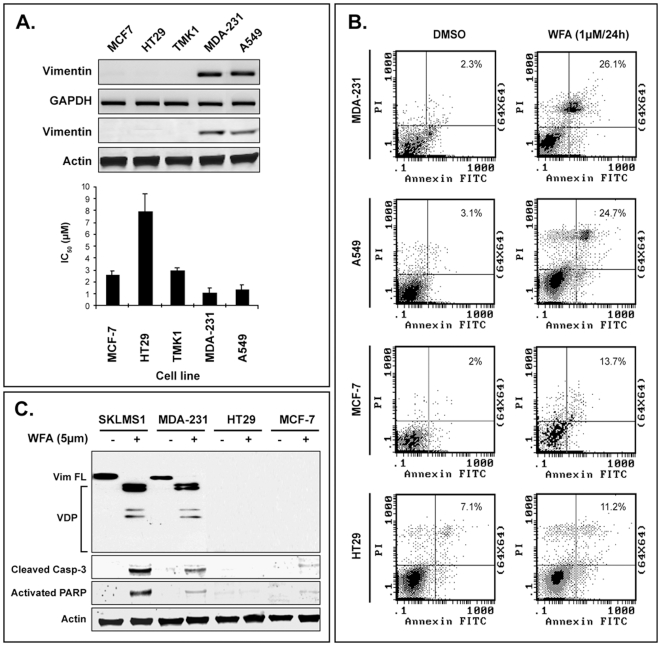
Epithelial origin cancers' sensitivity to WFA is enhanced in cells exhibiting epithelial to mesenchymal transition (EMT).
A) WFA-induced growth inhibition corresponds to vimentin expression level in epithelial origin cancer cells; B) WFA (1 µM for 24 h) elicits a significantly higher apoptotic rate in vimentin-expressing carcinoma cells; C) WB analysis demonstrating vimentin degradation MDA231 cells in conjunction with enhanced cleaved caspase-3 and activated PARP expression levels. In contrast, only minimal or no expression of cleaved caspase-3 and activated PARP are seen in the vimentin-negative MCF7 and HT29 cells. Graphs represent the average of three repeated experiments ±SD. (Vim FL  =  full length vimentin; VDP  =  vimentin degradation products)